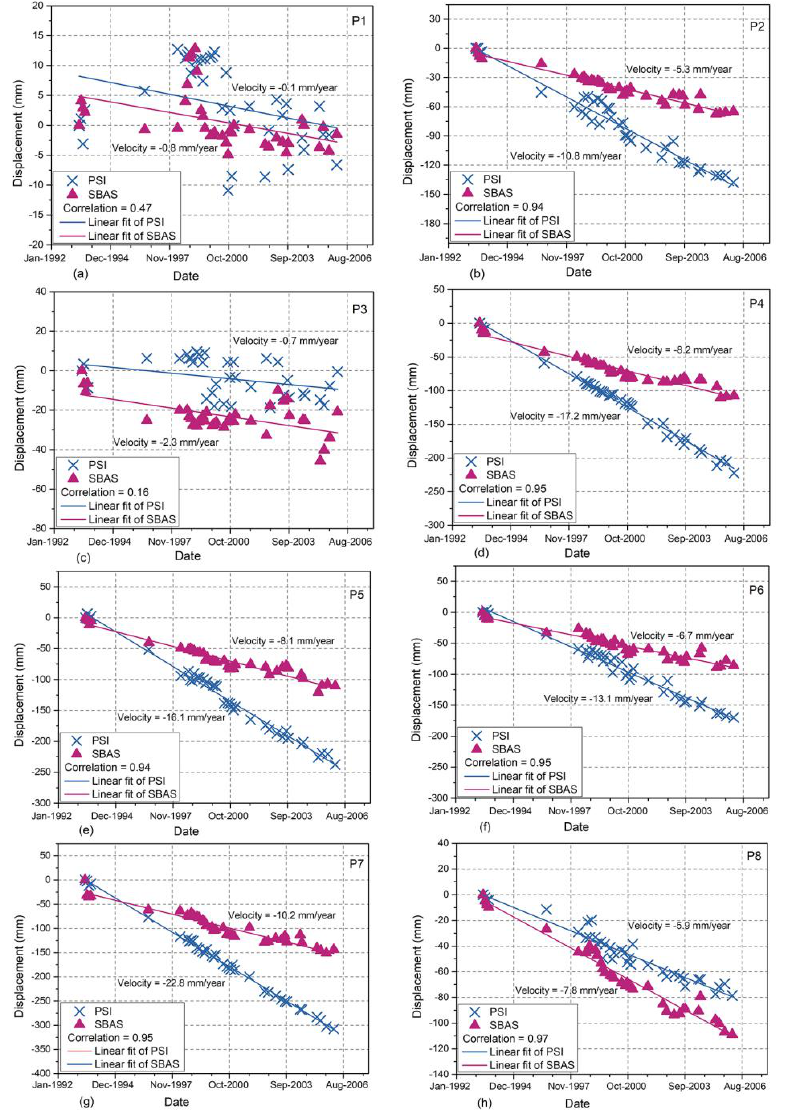
Figure 5. Time-series LOS displacement plots of the PSI and SBAS measurements from the ERS-1/-2 data ( a – h ) for the selected points P1 to P8, which are indicated by red points in Figure